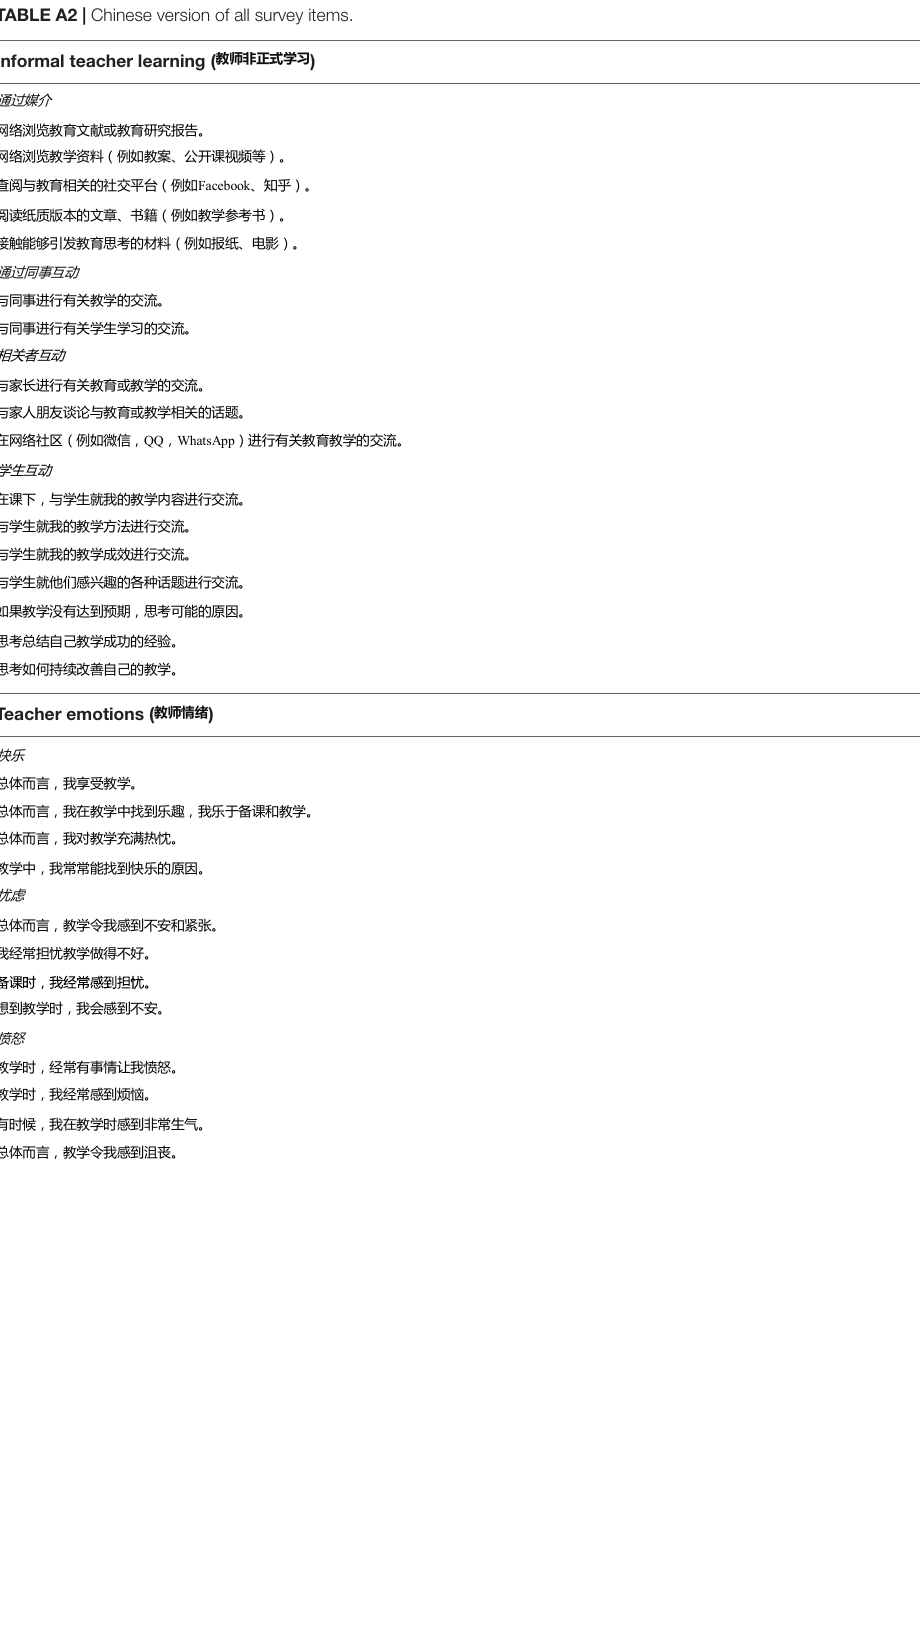
TABLE A2 | Chinese version of all survey